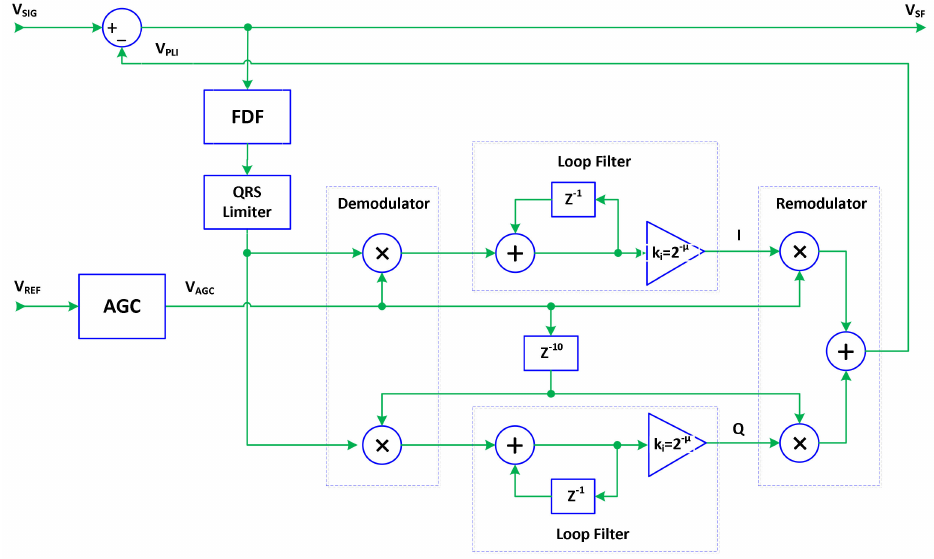
Figure 6. Optimized architecture of the closed-loop SF algorithm for PLI